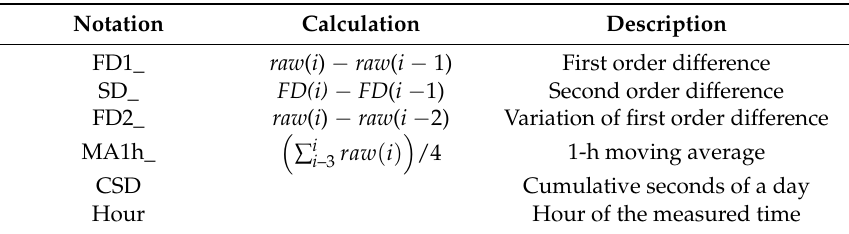
Table 5. Types and calculation methods of the derived